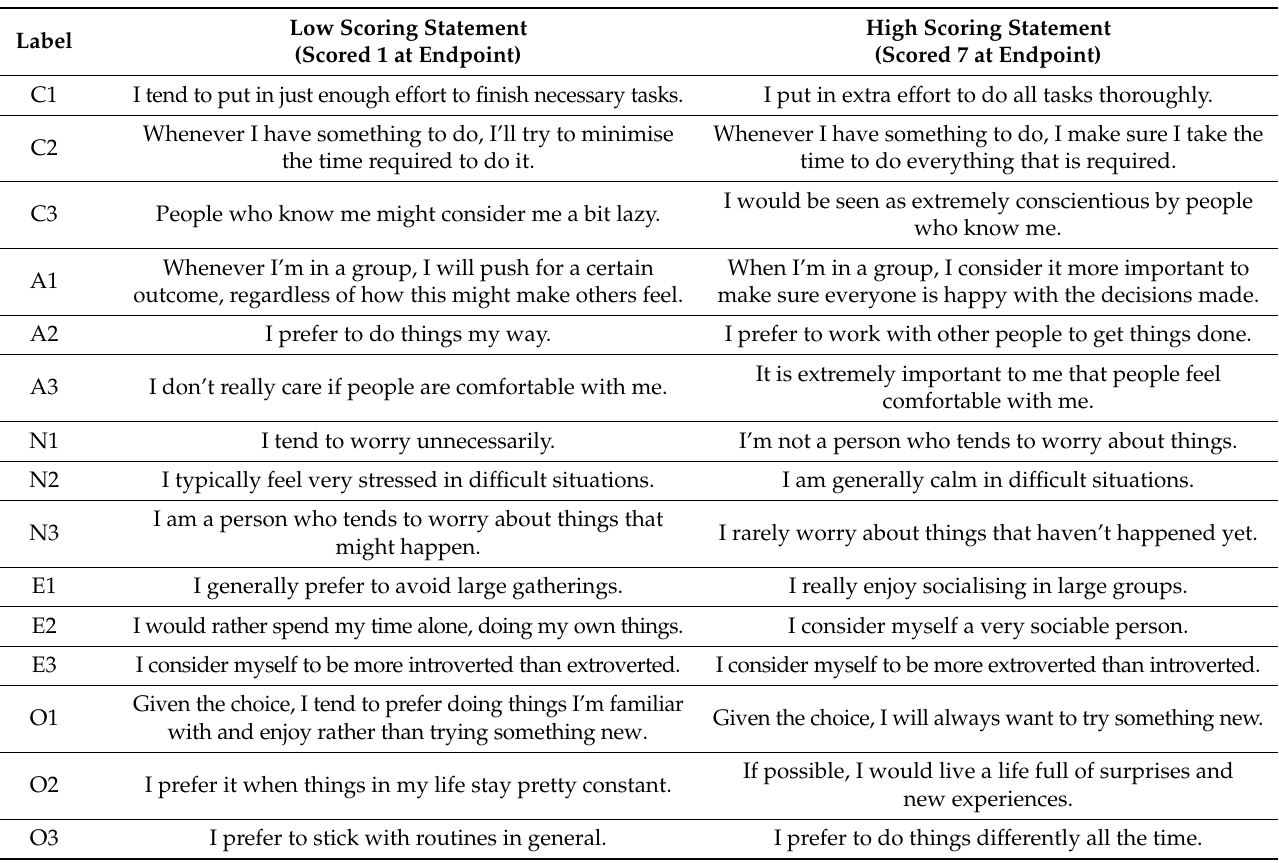
Table 1. Items and Statements for